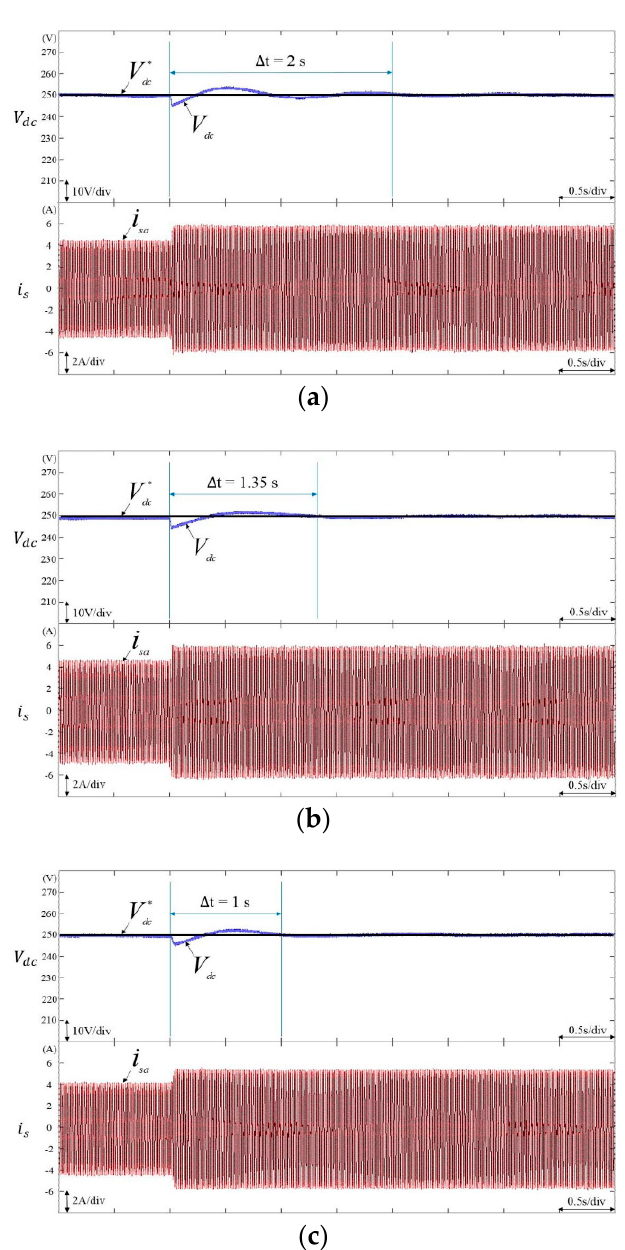
Figure 7. Experimental results at case 1: ( a ) Responses of DC-link voltage V dc and grid current i sa using PI controlled DSTATCOM; ( b ) Responses of DC-link voltage V dc and grid current i sa using CFNN controlled DSTATCOM; ( c ) Responses of DC-link voltage V dc and grid current i sa using proposed CFNN-AMF controlled DSTATCOM. Table 3. Response time of DC-link voltage and regulation voltage error for different controllers at case 1.